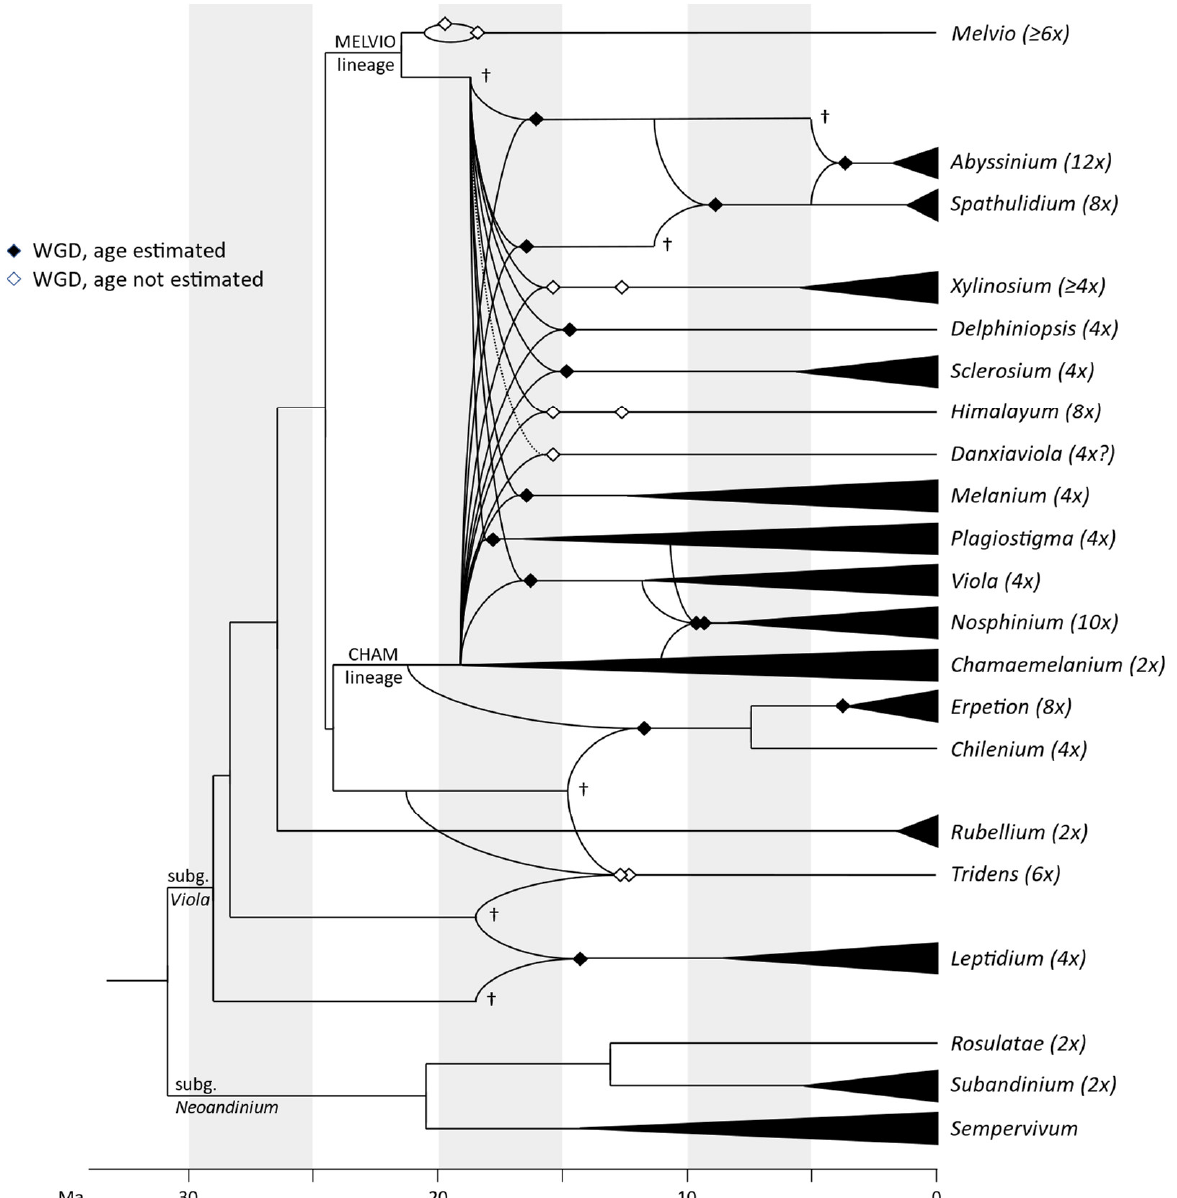
Figure 5. Dated phylogeny for monophyletic sections of Viola , updated from Marcussen et al. [28]. Estimated base ploidy is indicated after the name of each Viola section. Curved lines indicate parental lineages of an allopolyploid lineage and filled diamonds indicate the estimated time of allopolyploidisation [28]. Daggers denote parental lineages that are extinct or unsampled and extant only as a subgenome of an allopolyploid lineage. Horizontal black triangles indicate the estimated crown node of a section (and is prone to increase as more taxa are added). No phylogenetic data exist for sect. Nematocaulon and sect. Xanthidium of subg. Viola and for another seven sections of subg. Neoandinium .